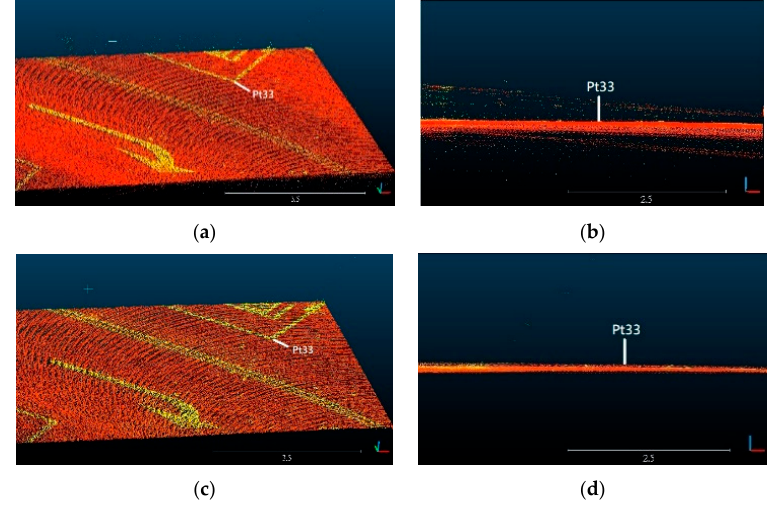
Figure 17. Top front view and side view of the Lidar points of an arrow sample near control point